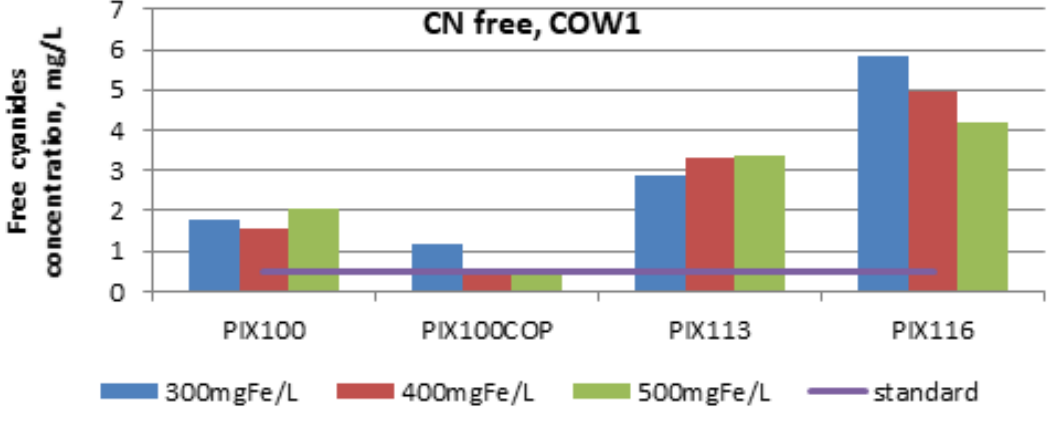
Figure 4: Final concentration of free cyanides in coke oven wastewater 1 (COW1).